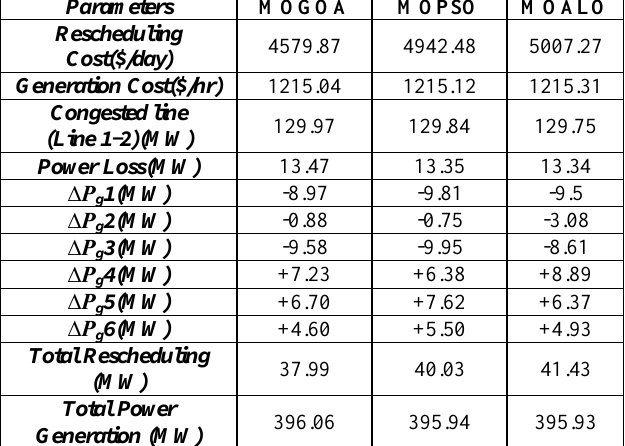
Figure 5. Voltage magnitude at each bus before and after CM (Case 2) Table 13.Comparison of MOGOA, MOPSO and MOALO for Case 1